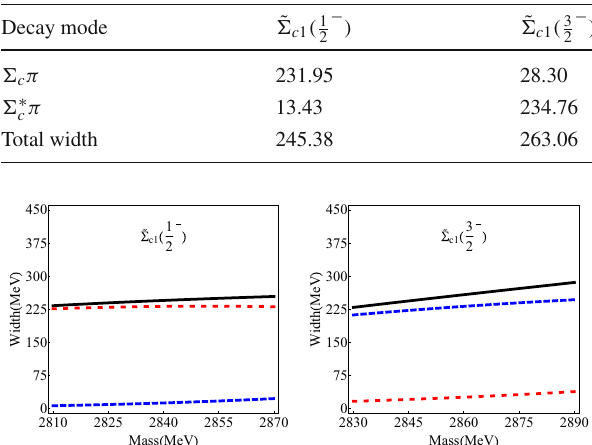
Table 7 Strong decays of the ˜ (cid:4) c ( 1 P ) states with the predicted masses in MeV Decay mode